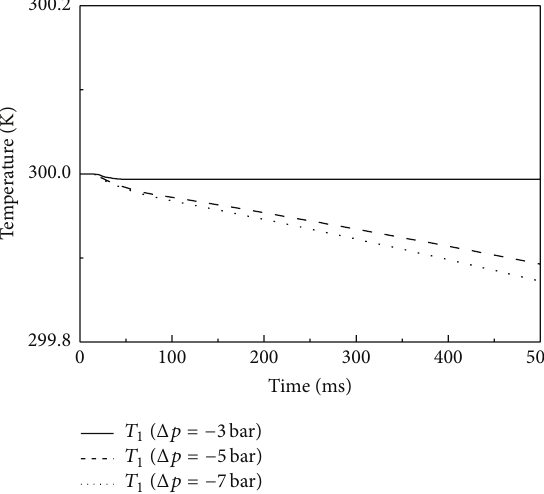
Figure 8: Temperature evolutions in insulation chamber at depres- surization